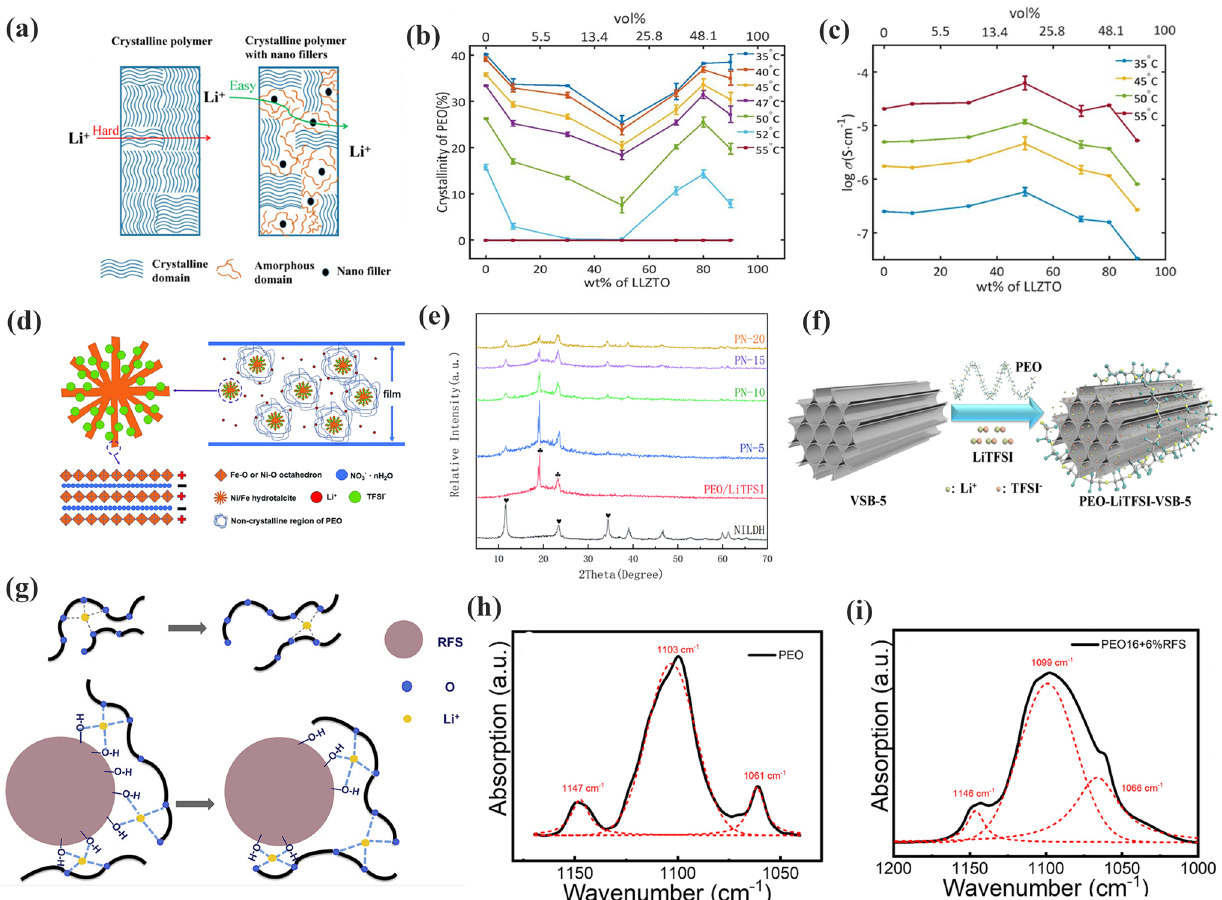
Fig. 12 a Schematic illustration of the lithium-ion transfer across crystalline polymer and crystalline polymer with nanofillers; b Xc of PEO on LLZTO contents; c the dependence of ionic conductivity on LLZTO contents. Adapted with permission from Ref. [149]. d Structure sketch of NILDH-PEO CPEs improving the ionic conductivity; e XRD patterns of NILDH and NILDH-PEO CPEs. Adapted with permission from Ref. [150]. f VSB-5-enhanced SPEs for lithium battery. Adapted with permission from Ref. [151]. g Schematic diagram of RFS effect the lithium-ion conduction; h-i Attenuated total reflection infrared spectra of PEO and PEO16-RFS. Adapted with permission from Ref.